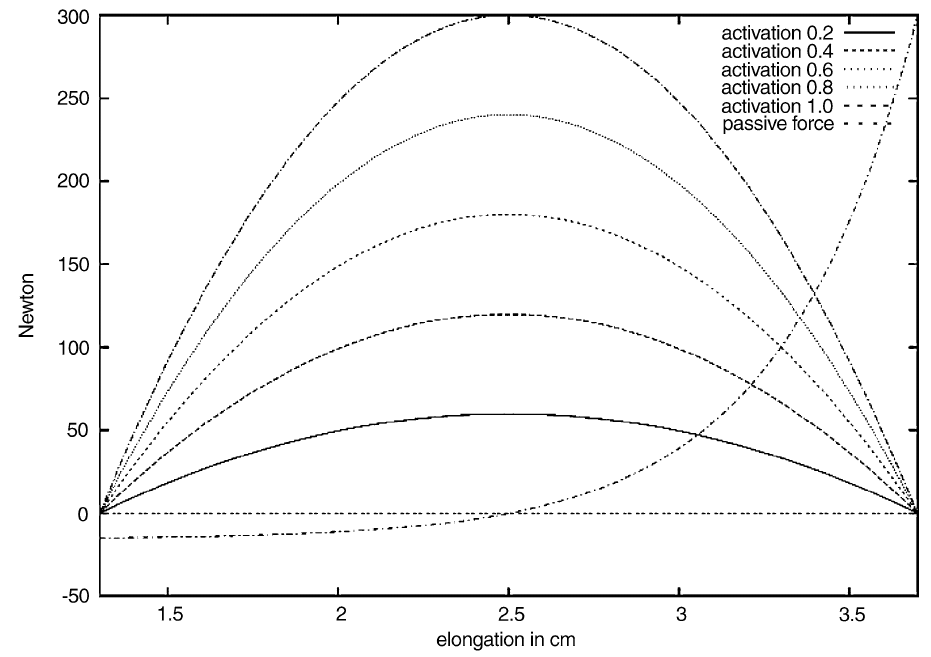
Figure 2. An exemplification of how the force exhorted by a muscle . The graph shows how the force exhorted by a muscle varies as a function of the activity of the corresponding motor neuron and of the elongation of the muscle for a joint in which T max is set to 300N.